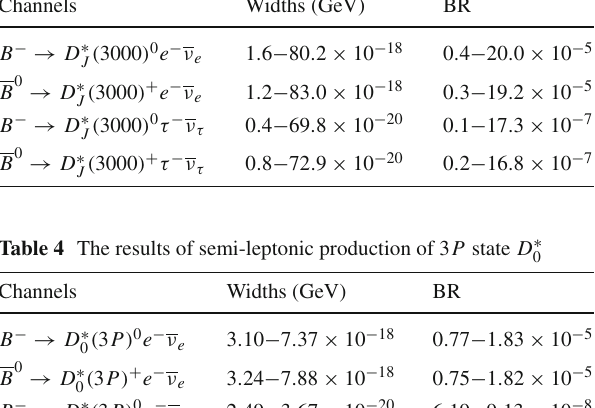
Table 3 The results of semi-leptonic production of 2 P state D ∗